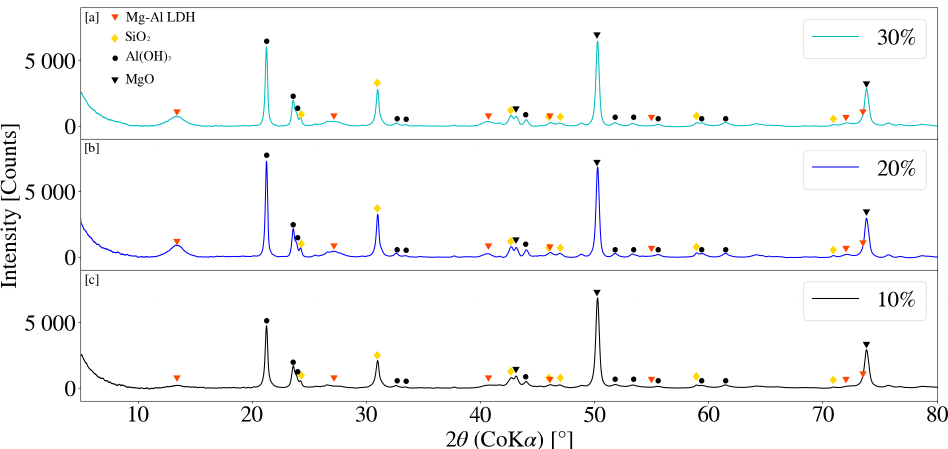
Figure 12. ( a ) X-ray diffraction pattern for Mg-Al LDH sample synthesised with a 30% solids loading (S8). ( b ) X-ray diffraction pattern for Mg-Al LDH sample synthesised with a 20% solids loading (S7). ( c ) X-ray diffraction pattern for Mg-Al LDH sample synthesised with a 10% solids loading (S2). Milling parameters were set at a rotational speed of 2000 rpm, media size of 2 mm, jacket water inlet temperature of 30 °C and a retention time of 1